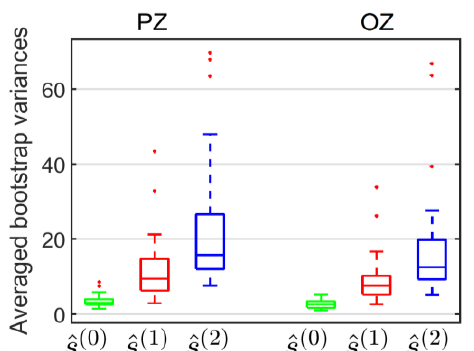
Figure 7 Averaged bootstrap variances for the three estimations of the evoked potential at stimulus onset, on PZ and OZ electrodes: by average 𝑠̂ (0) (𝑡) , by the two-class GLM 𝑠̂ (1) (𝑡) and by the three-class GLM 𝑠̂ (2)